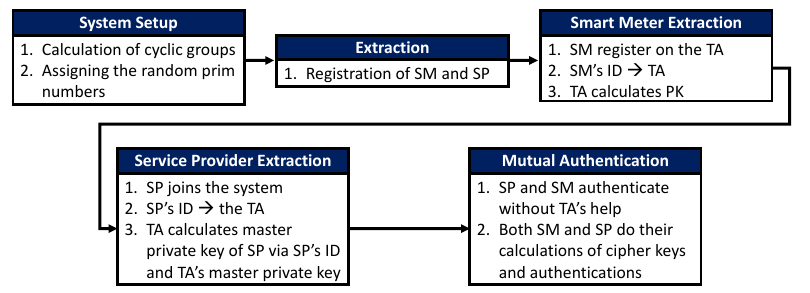
Figure 8. General architecture of anonymous key distribution.